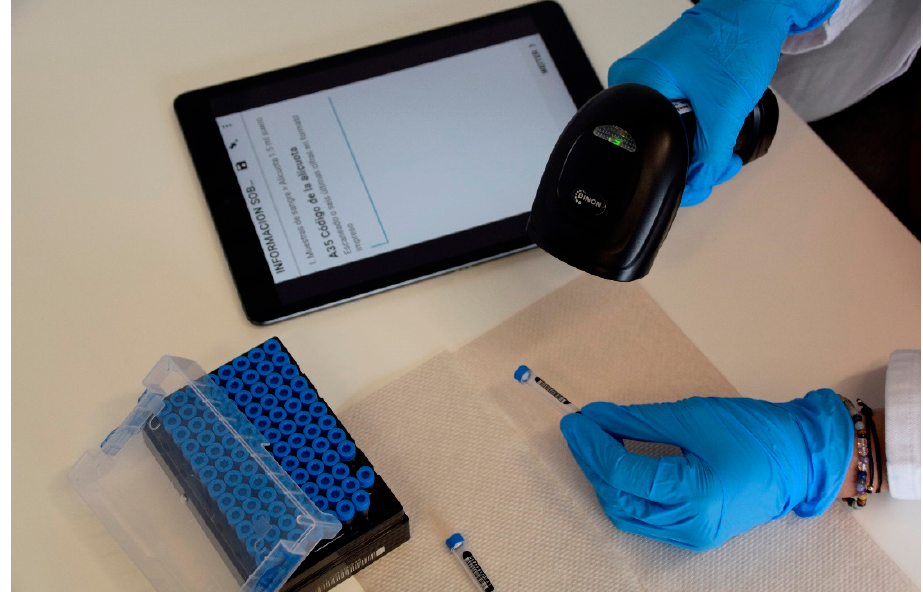
Figure 4. Second module of EULAT eCollect (Sample Information). The application allows barcodes to be scanned using a barcode reader or the camera of the device on which EULAT eCollect is installed (e.g., tablet or smartphone), minimising errors and reducing the time spent documenting sample characteristics during sample processing.